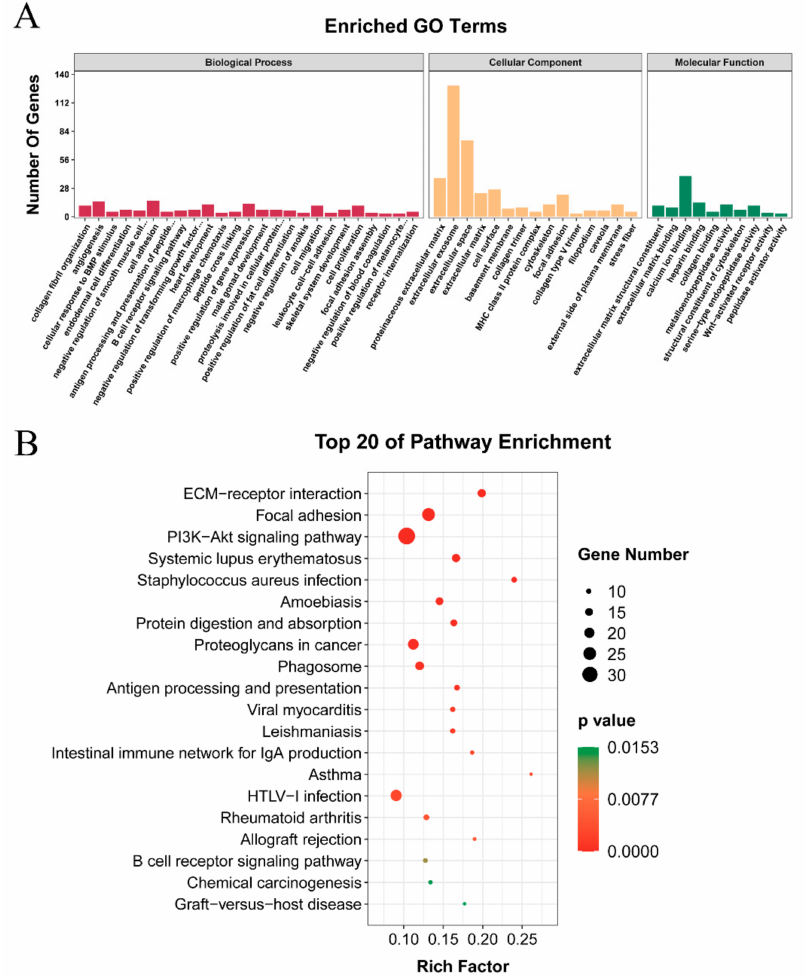
Figure 5. Functional enrichment analyses of the candidate genes: ( A ) GO functional annotation of the candidate genes related to precocious puberty. The X-axis indicates the detailed terms, and the Y-axis indicates the gene numbers; ( B ) KEGG pathways of candidate genes related to precocious puberty. The X-axis indicates the gene ratio, and the Y-axis indicates the name of KEGG pathway. The size of dots indicates the numbers of genes, and the color of dots indicates p